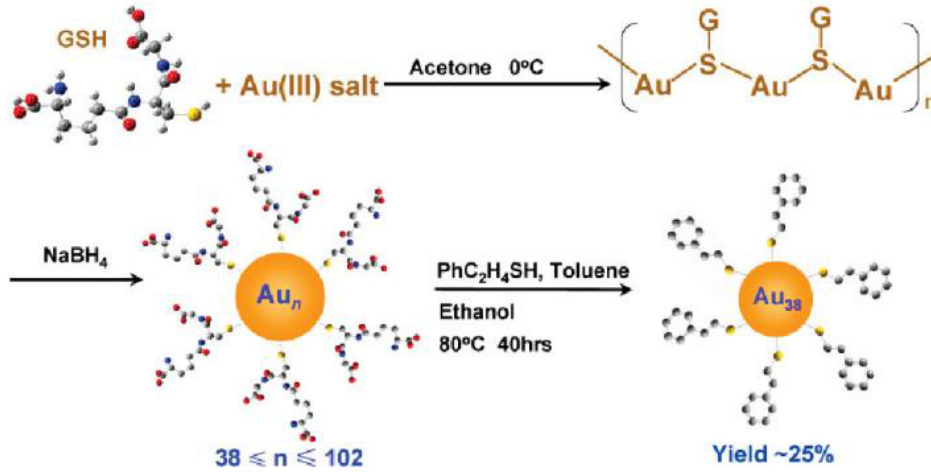
Figure 2. Mechanism diagram of preparation of monodisperse Au 38 (SC 2 H 4 Ph) 24 clusters by thermal